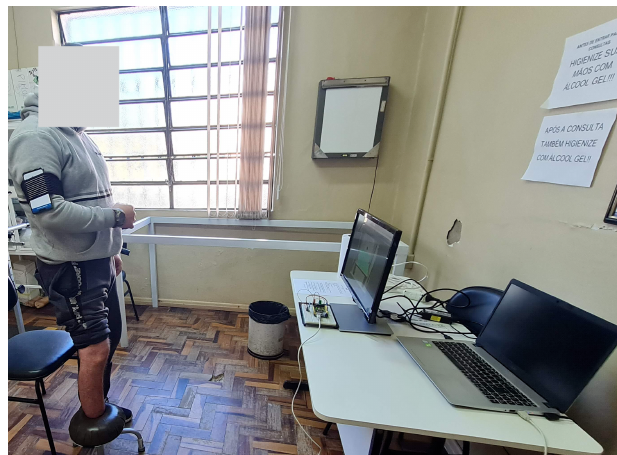
Figure 12. Validation of the solution with the patient 1. Source: Author (2022).